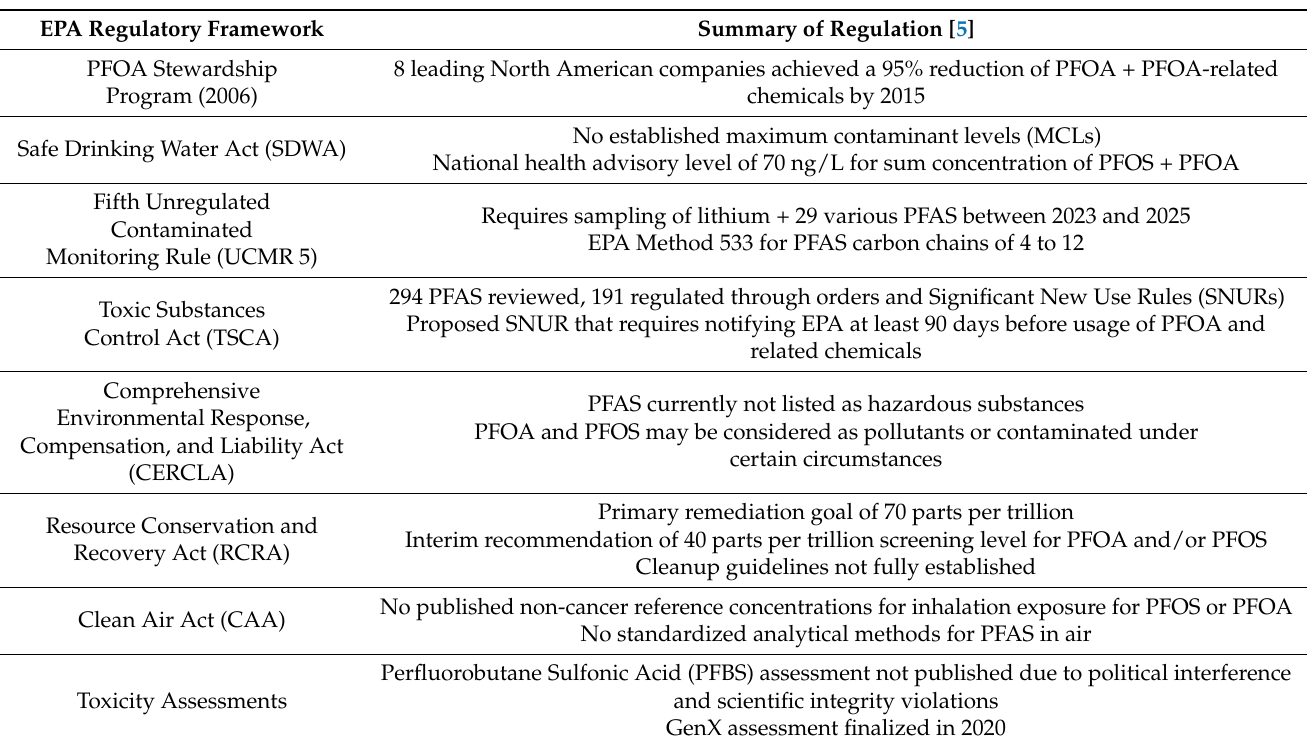
Table 2. Summary of U.S. Environmental Protection Agency’s (EPA) Regulatory Framework